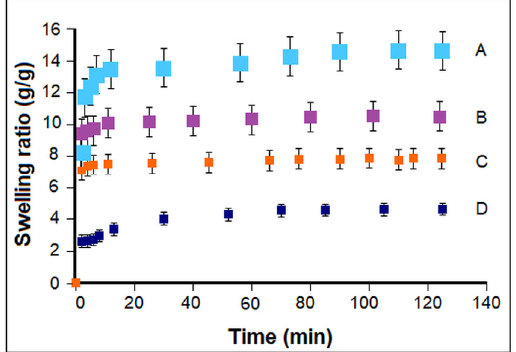
Figure 9. Swelling kinetics of the prepared cryogel constructs for different composition, morphol ‐ ogy, and architecture: